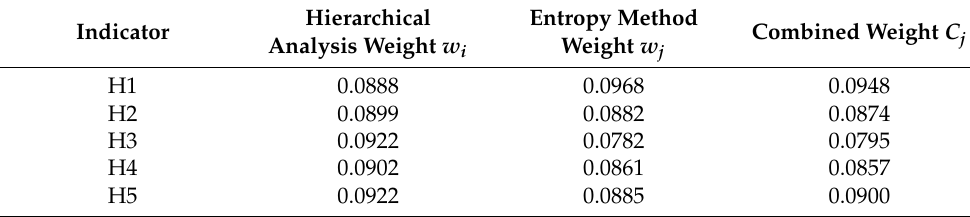
Table 15. Comprehensive weight results (scheme layer) obtained by two weighting methods.